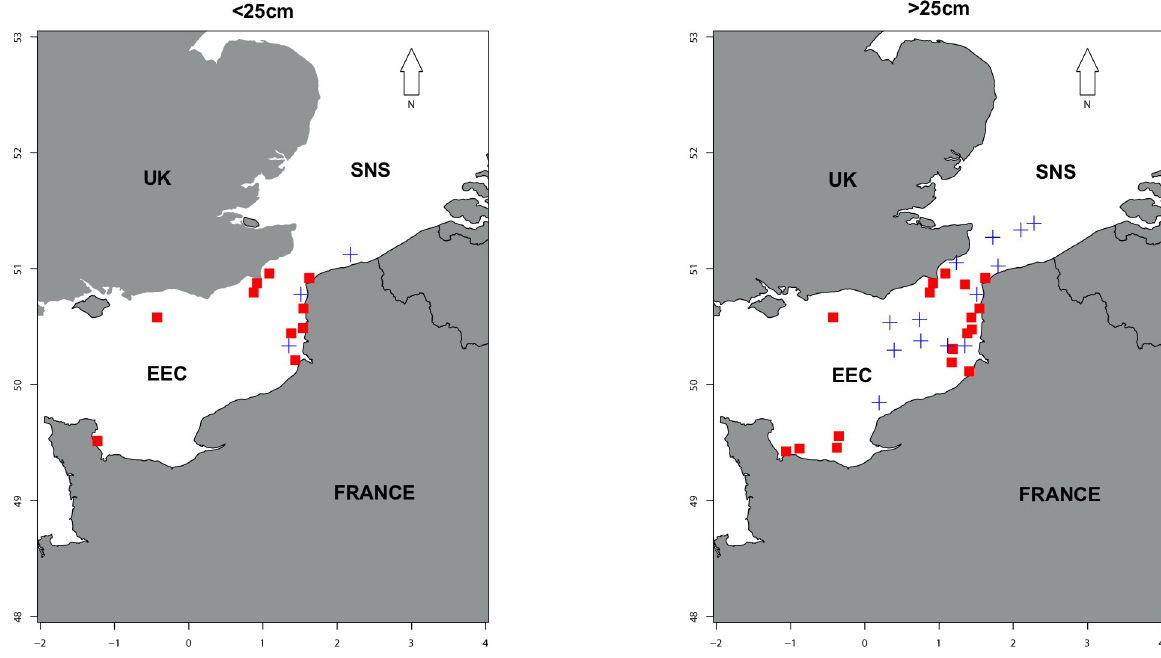
Fig 1. Localization of stations sampled during the two surveys: CGFS 2017 (red squares, autumn 2017) and IBTS 2018 (blue cross, winter 2018). Left: sampling locations of fish smaller than 25cm. Right: sampling locations of fish larger than 25cm.